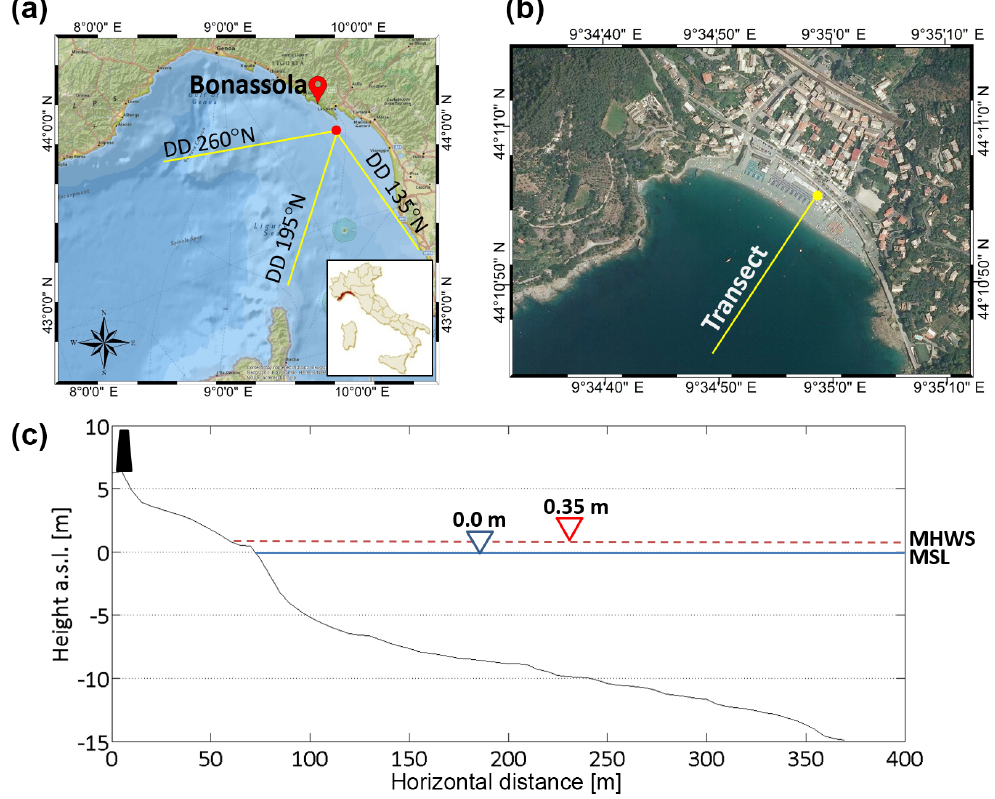
Figure 1. Bonassola beach study area with (a) the location of the La Spezia SWAN buoy (red circle) and the main and secondary fetches (image source: National Geographic); (b) the monitored cross-shore transect with video camera system location (yellow circle) (image source: http://www.pcn.minambiente.it/mattm/servizio-wms/, last access: 15 June 2018); (c) the beach profile along the transect with the location of the anthropic structures (black trapezium), mean sea level (MSL) and the mean spring tidal range (MHSW) was extracted by the official Italian tide archives (http://www.mereografico.it, last access: 4 December